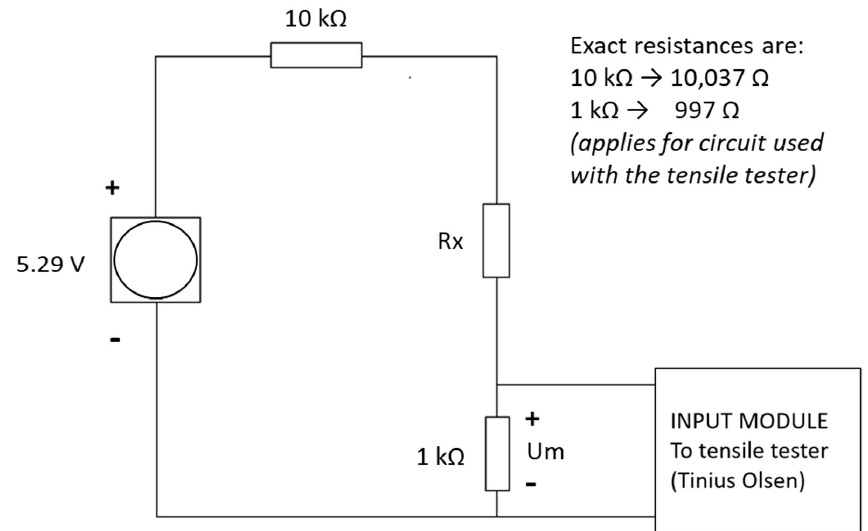
Figure 9. The measuring circuit diagram for dynamic pressure vs. resistance testing on the flat.